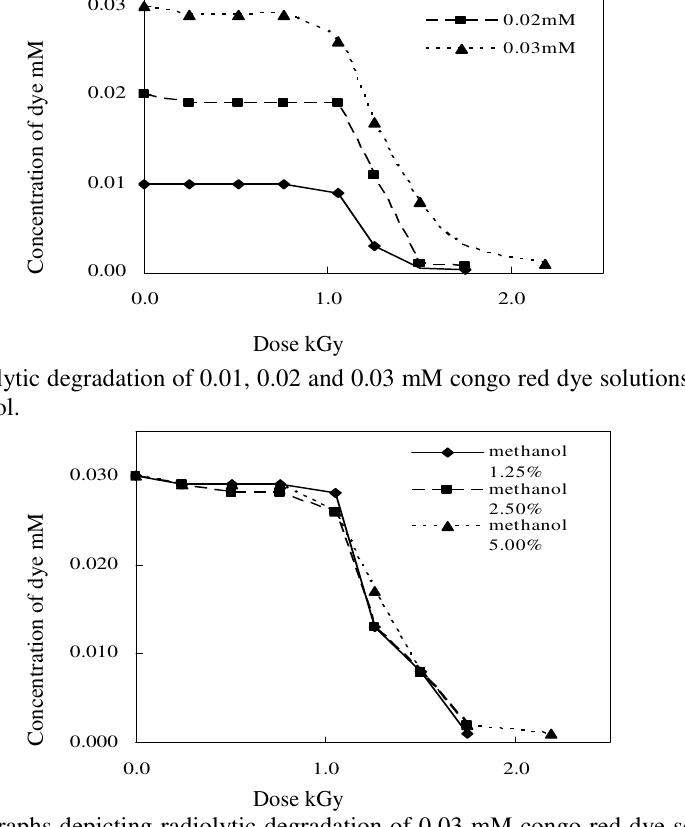
Figure 3. The graphs depicting radiolytic degradation of 0.03 mM congo red dye solutions containing 1.25%, 2.5% and 5%